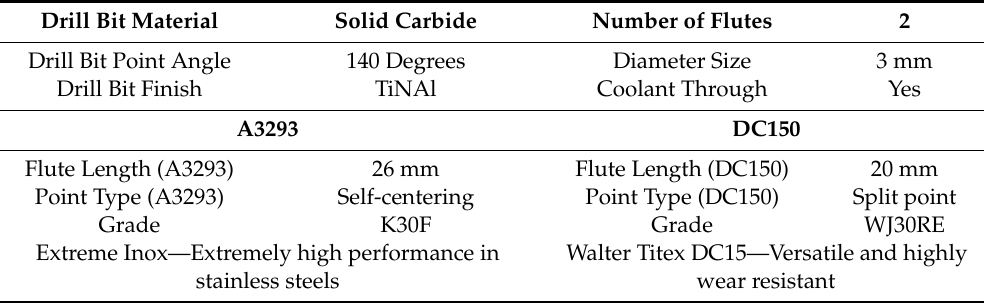
Figure 5. Drilling tools used. ( a ) Coating Grade: K30F (A3293TTP-3); ( b ) Coating Grade: WJ30RE (DC150-03). Table 2. Tested materials’ composition and hardness.